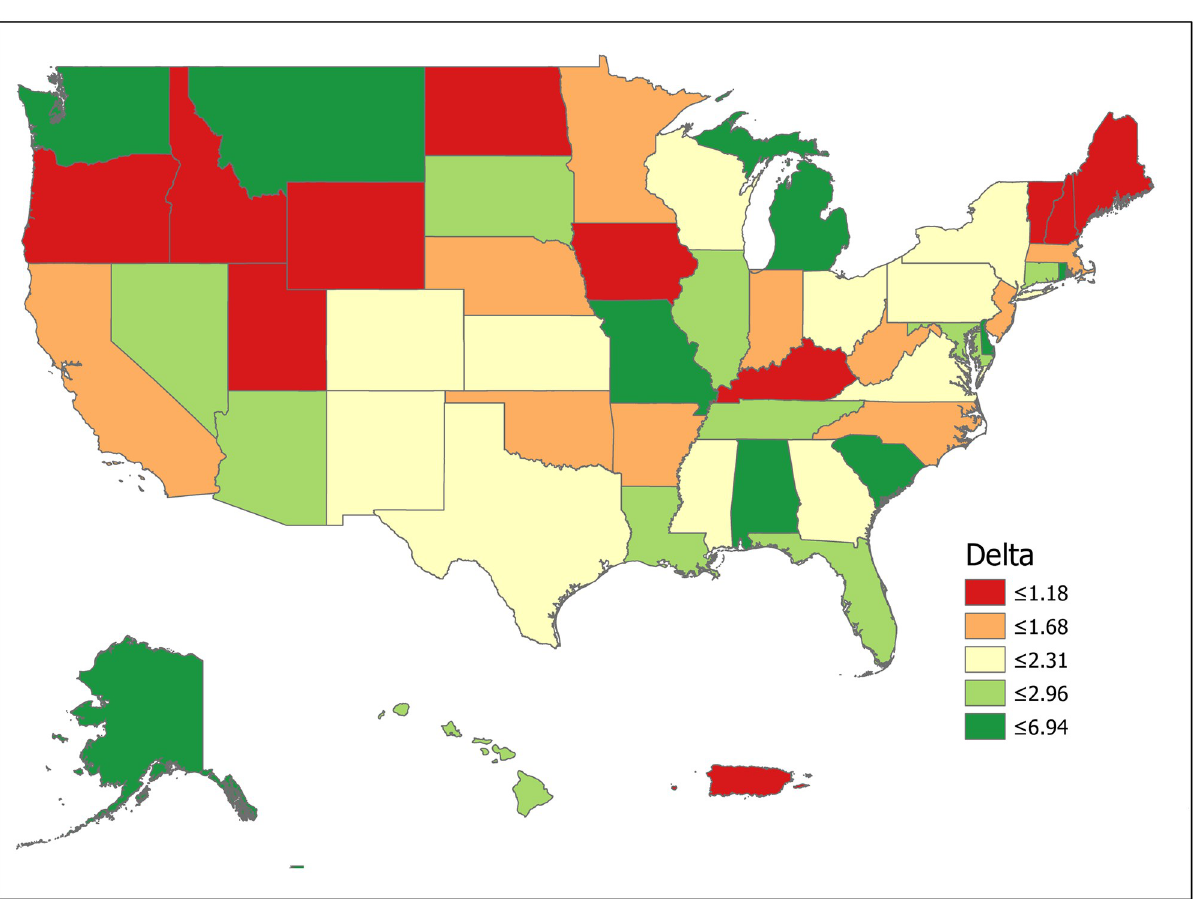
Fig 6. 2018 estimated value of an additional registered donor ( Δ ). Data come from Tables 1 and 2. Maps created by ArcGIS Pro, URL: https://www. esri.com/en-us/arcgis/products/arcgis-pro/overview. Base Map: World Light Gray Base, URL: https://services.arcgisonline.com/arcgis/rest/services/ Canvas.